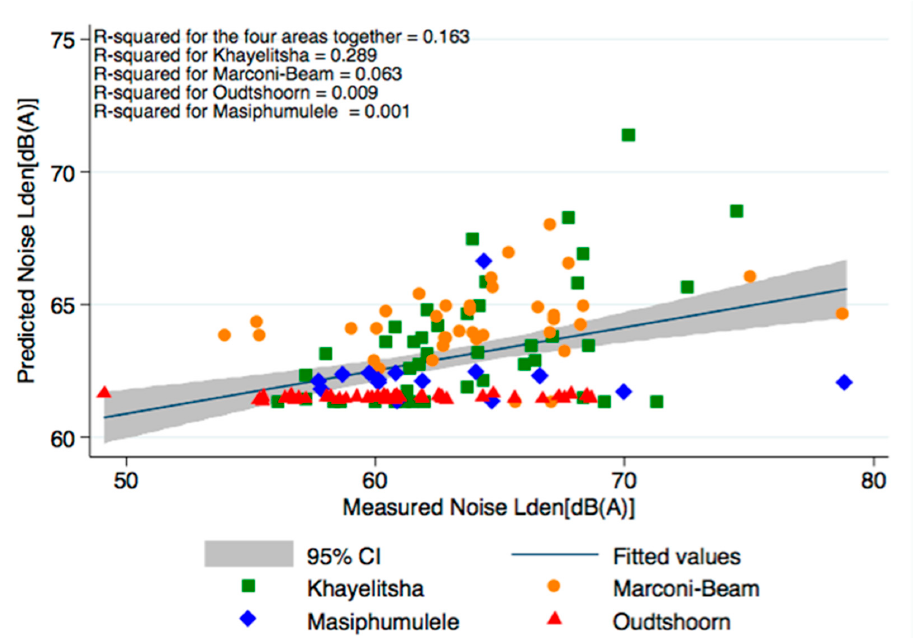
Figure 1. Scatter plot of the predicted noise (L den ) against the measured noise (L den ), with different symbols for each of the four study areas (Khayelitsha with n = 42, Marconi ‐ Beam with n = 37, Masiphumulele with n = 16, and Oudtshoorn with n = 39). The fitted value line and the 95% confidence interval (grey zone) are also represented, as well as the R 2 giving the relationship between the noise predicted and the noise measured.